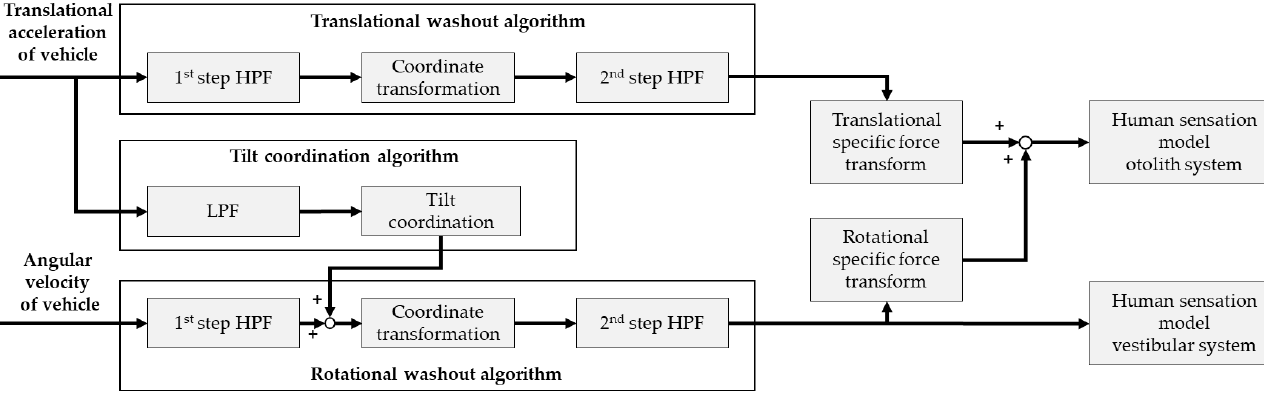
Figure 13. Simulation diagram for the motion sensation by the proposed washout algorithm. Table 4 represents correlation coefficient between the motion sensation of the actual vehicle and motion sensation of classical washout algorithm and proposed washout algo- rithm. The closer the correlation coefficient value is to one, the more similar it can be to the actual motion sensation.